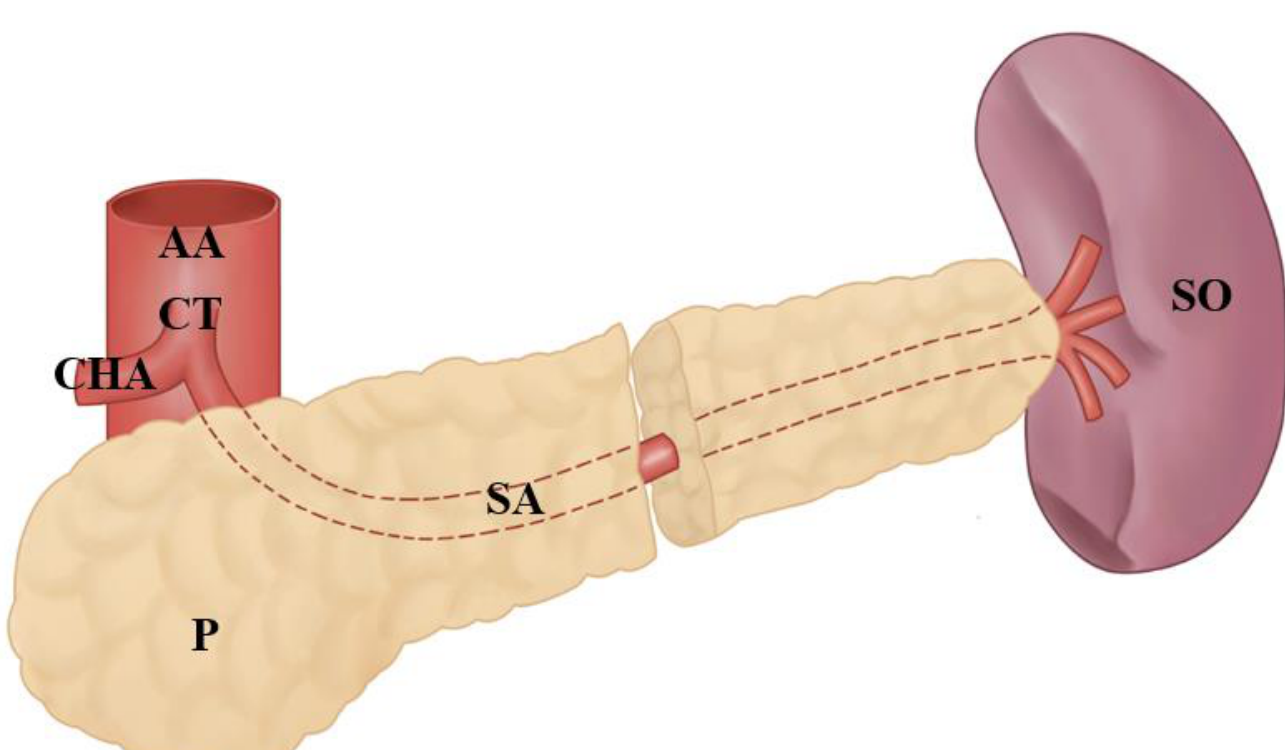
Figure 6. The image shows the intrapancreatic splenic artery. Abbreviations: abdominal aortic (AA), splenic artery (SA), common hepatic artery (CHA), celiac trunk pancreas (P), splenic organ (SO).